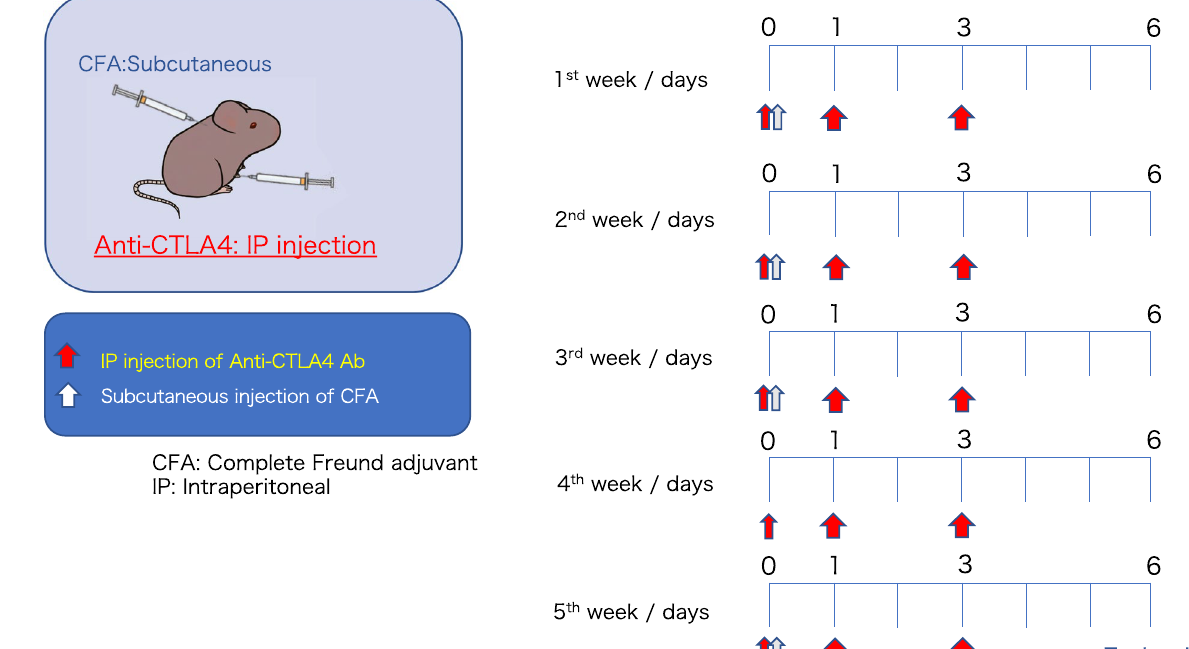
Figure 1. Schedule of anti-CTLA4 and complete Freund adjuvant injections in mice. IP: